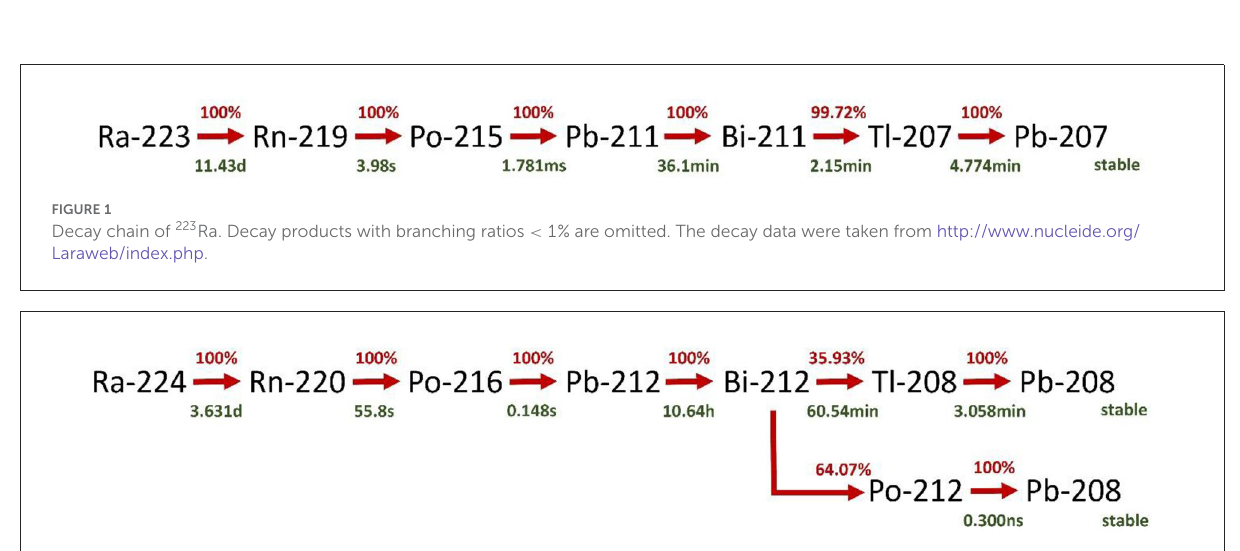
FIGURE2 Decay chain of 224 Ra. Decay products with branching ratios < 1% are omitted. The decay data were taken from http://www.nucleide.org/